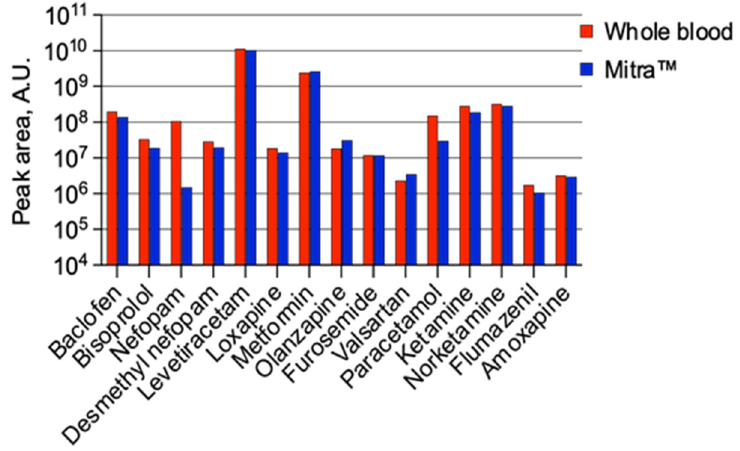
Figure 4. Details of the molecules identified in patient P2 in the whole blood samples and Mitra TM device. A.U.: Arbitrary Unit.